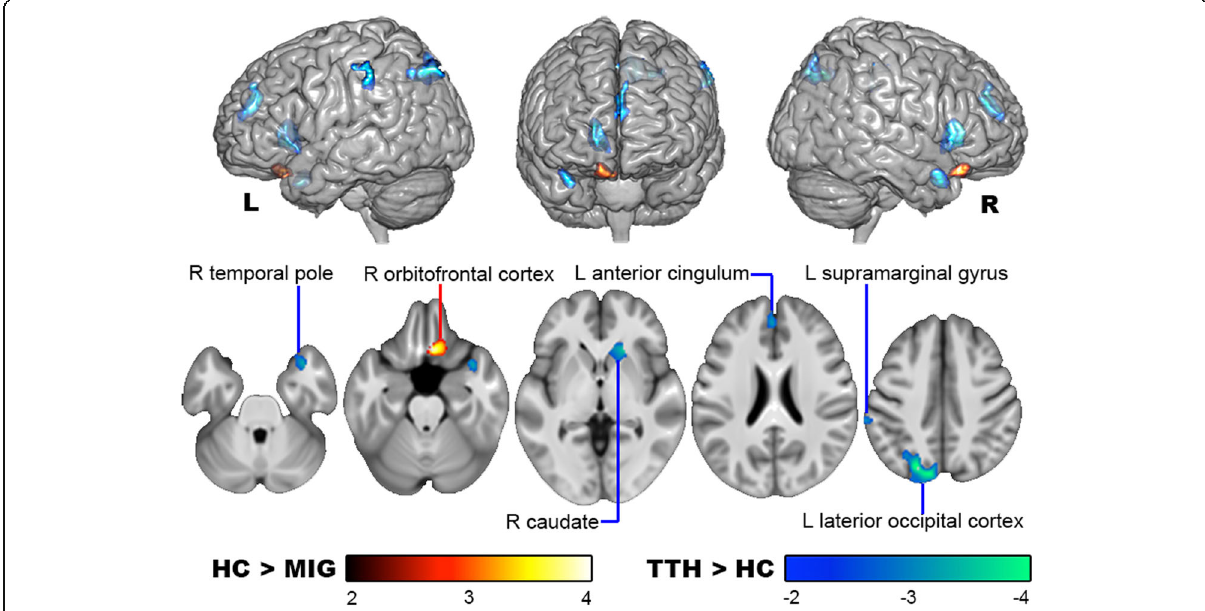
Fig. 1 Altered gray matter volume in TTH and migraine. In comparison with controls, the patients with TTH exhibited a gray matter volume increase in the anterior cingulate cortex, supramarginal gyrus, temporal pole, lateral occipital cortex, and caudate. The patients with migraine conversely exhibited a gray matter volume decrease in the orbitofrontal cortex. HC: healthy controls; L: left; MIG: migraine; R: right; TTH: tension-type